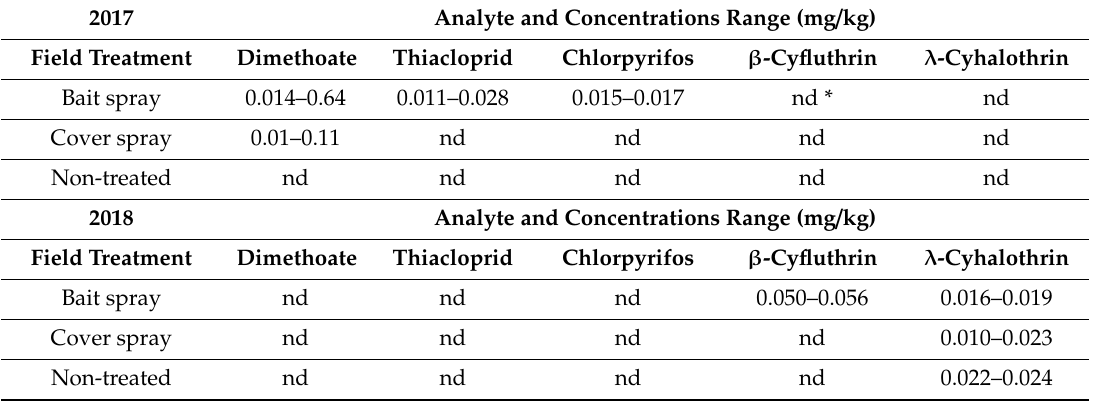
Table 4. Pesticides and concentration ranges in 2017 and 2018 olive oil